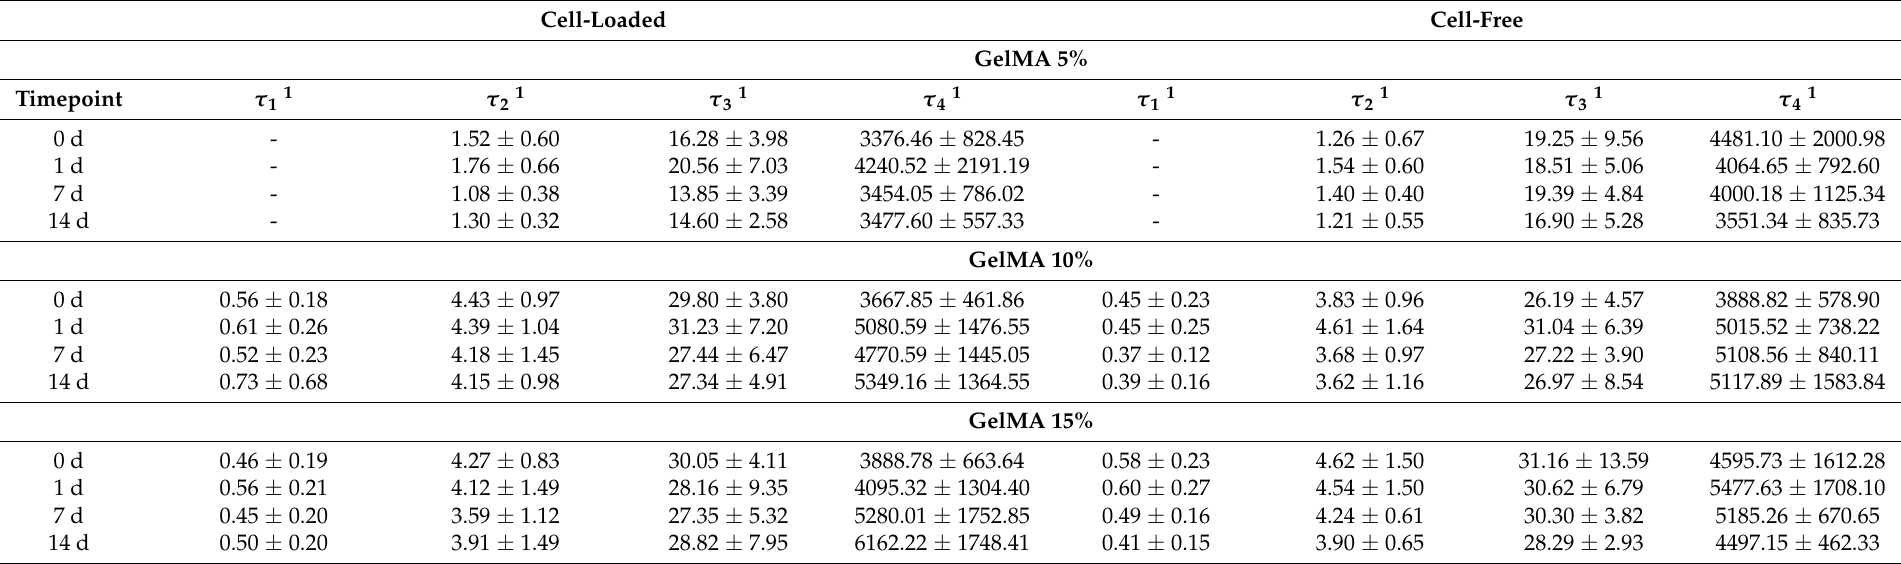
Table 1. Tau ( τ ) values in seconds (s) of each Maxwell element per GelMA concentration and timepoint. Cell-Loaded Cell-Free GelMA